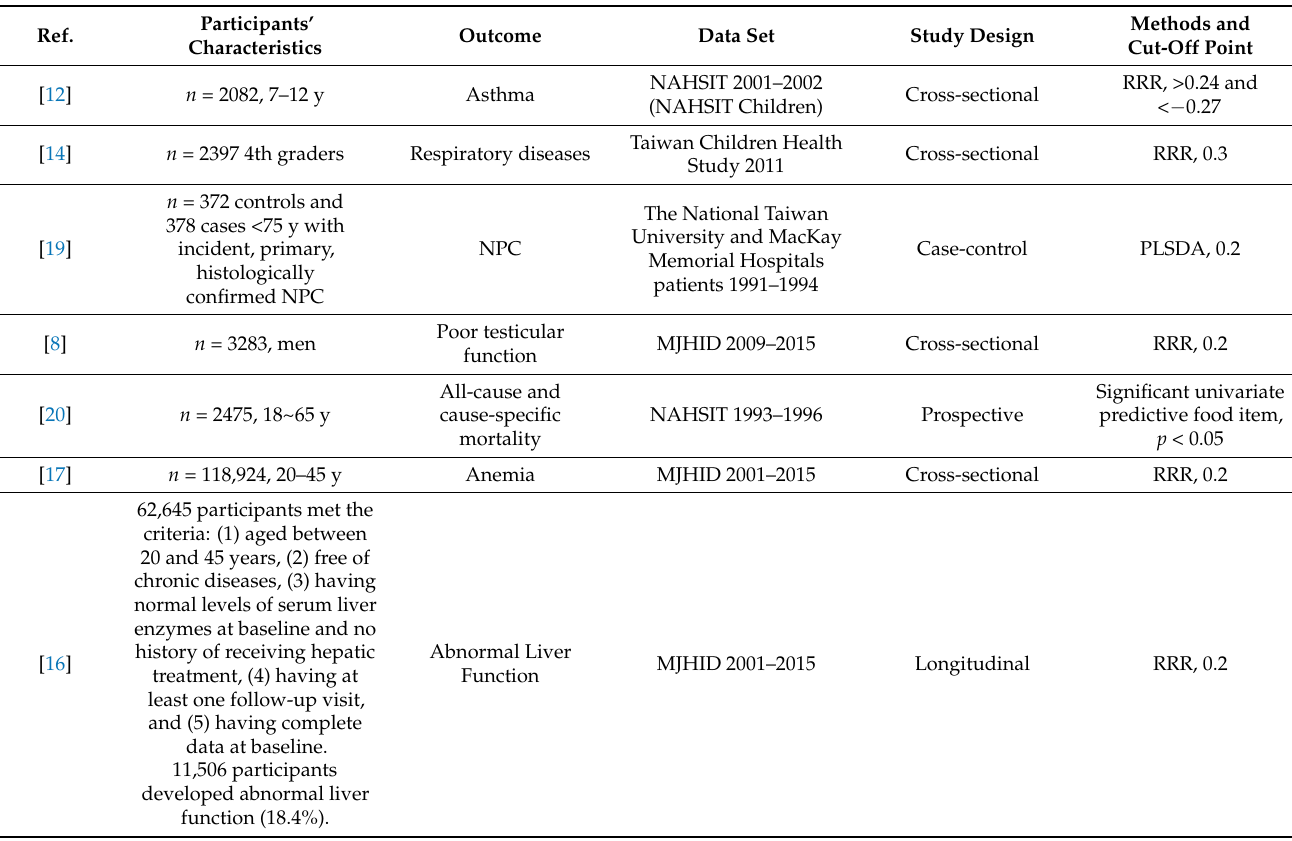
Table 1. Description of the included data mining dietary pattern studies. Ref.